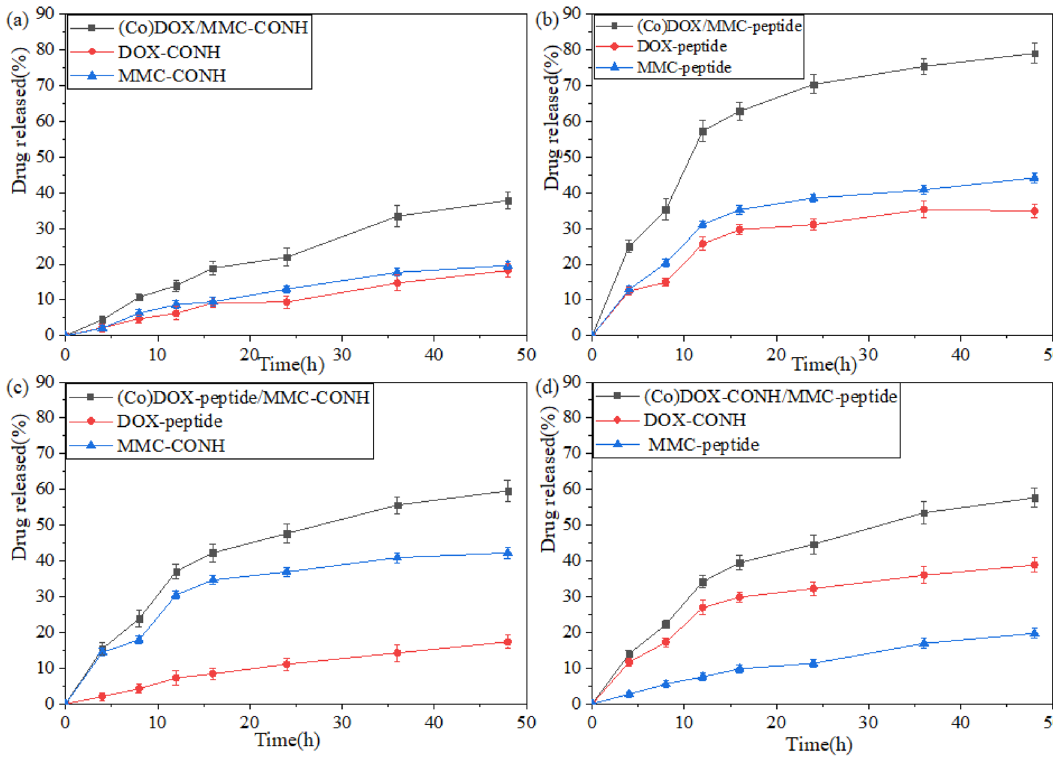
Figure 5. ( a ) Release profiles of (Co)DOX/MMC-CONH, DOX-CONH, MMC-CONH ( b ) Release profiles of (Co)DOX/MMC-peptide, DOX-peptide, MMC-peptide ( c ) Release profiles of (Co)DOX-peptide/MMC- CONH, DOX-peptide, MMC-CONH ( d ) Release profiles of (Co)DOX-CONH/MMC-peptide, DOX-CONH, MMC-peptide. Data were given as mean ± SD (** p < 0.05).